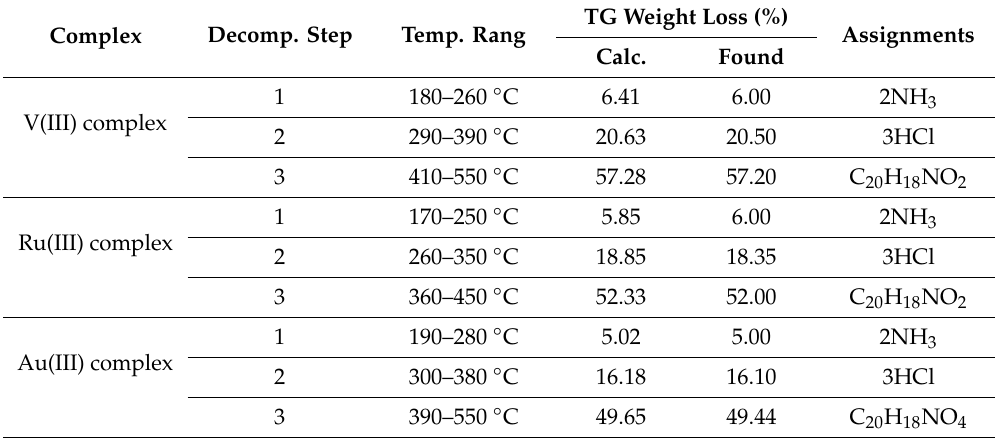
Table 5. TGA data for V(III), Ru(III) and Au(III)–papaverine